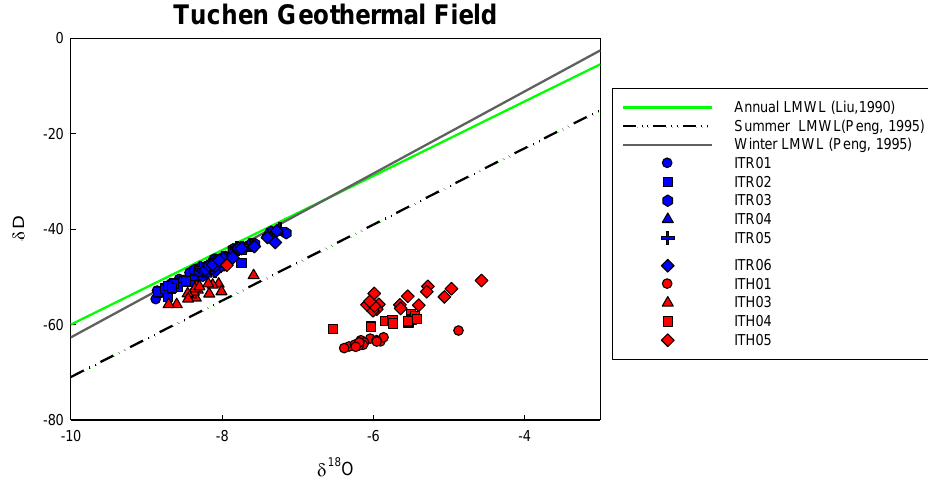
Figure 4. Plot of stable isotopes in the Tuchen geothermal field. Blue color represents surface water, and red color represents groundwater. However, the characteristic of ITH03 is similar to that of surface water. A shift of the thermal water with a relative constant δD from the local mean meteoric water line (LMWL) indicates a slow fluid–rock interaction process in the study area.